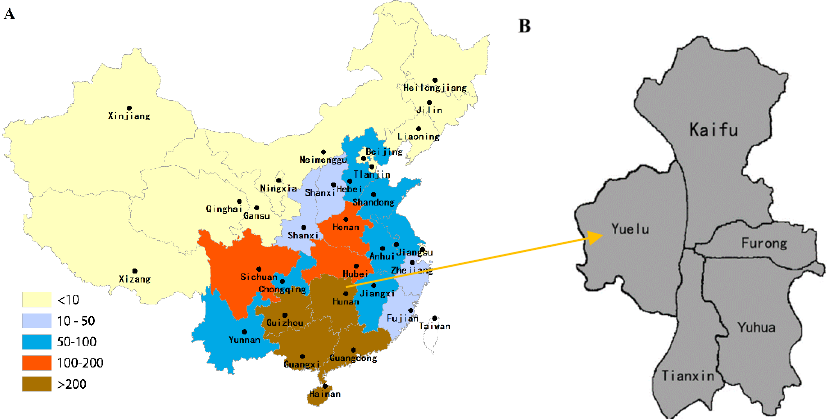
Figure 1. The regional distribution of averaged number (year) of rabies cases ( A ) (the figure is from Yong ‐ Chao Qiao, et al. [12]) and administrative division, Changsha urban area, China, 2021 ( B ). Changsha, the capital city of Hunan Province, is in the middle of China, and mainly in- cludes five urban areas, namely Kaifu, Furong, Yuelu, Tianxin, and Yuhua (Figure 1). According to the seventh census, the resident population of Changsha (urban areas) reached 3.482 million, and the area of Changsha (urban areas) is 434.82 square